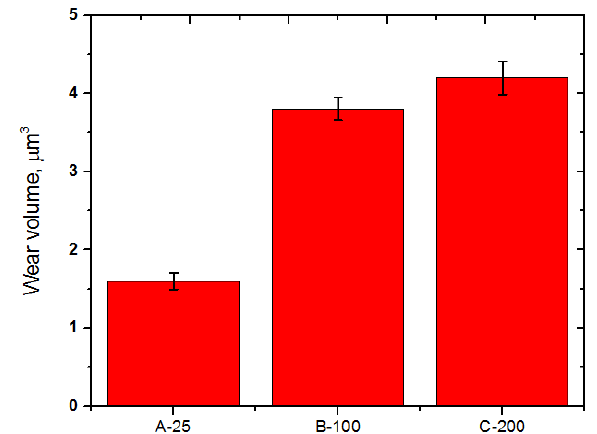
Figure 11. SEM images and EDS patterns of wear scars formed on the AISI52100 steel ball slid against the C/C-SiC composite at temperatures of 25, 100 and 200 °C.